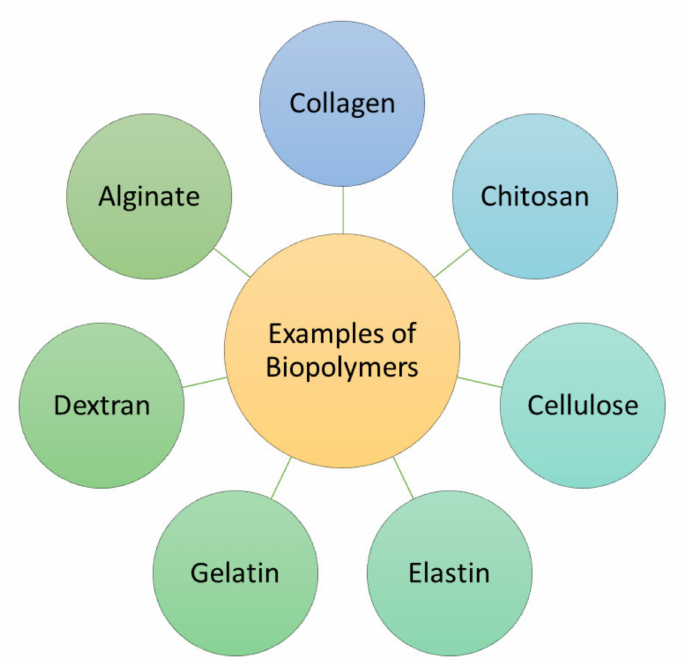
Figure 1. Examples of some biopolymers that are used in tissue regeneration and wound